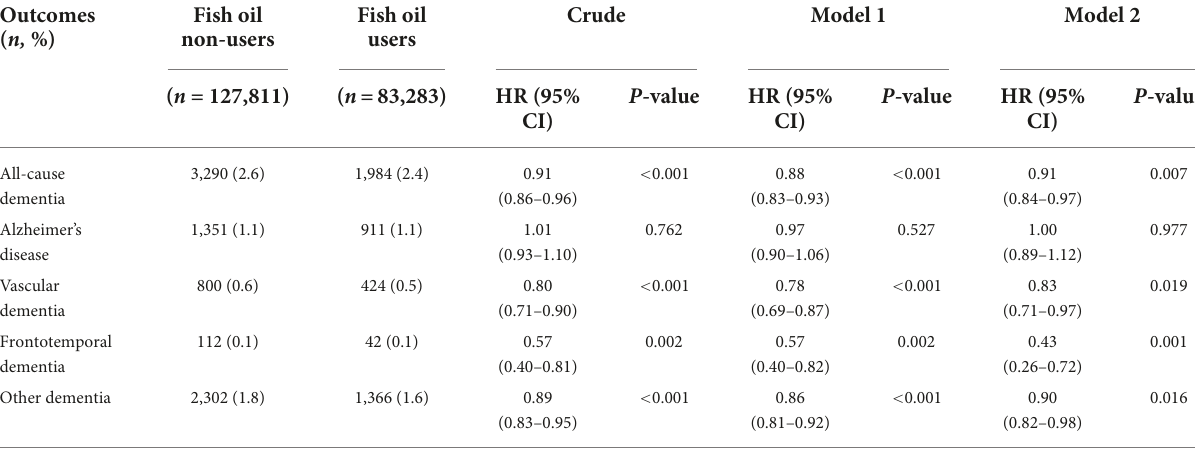
TABLE 2 Associations of use of fish oil supplements with the risk of dementia. Outcomes ( n,